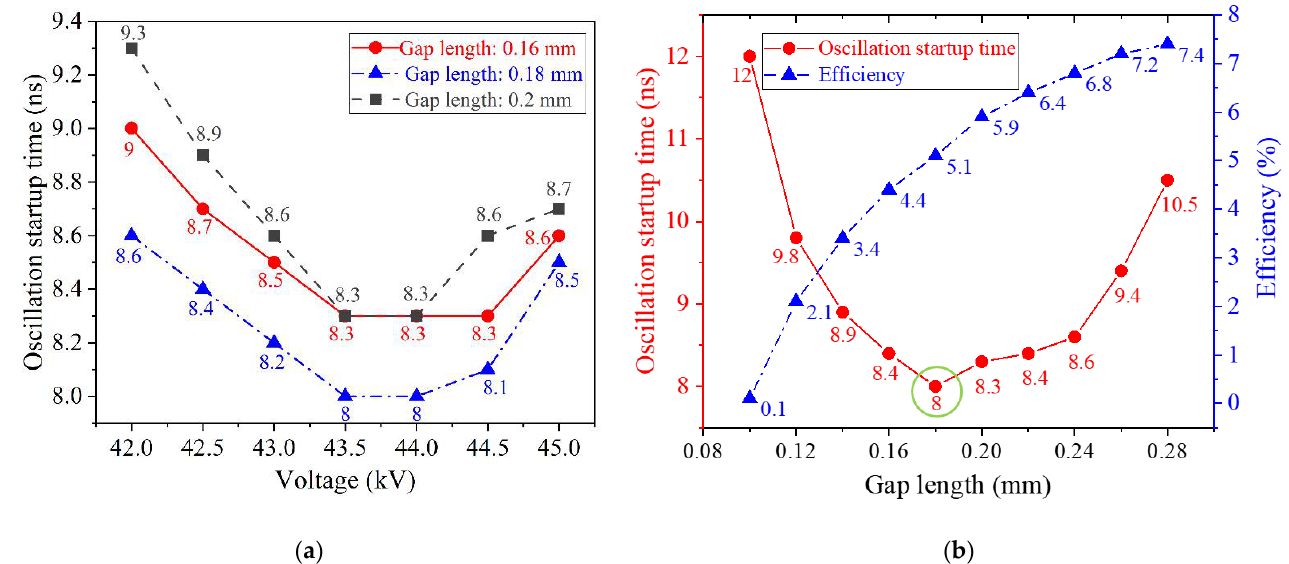
Figure 8. ( a ) The change trends of the EIO’s OST with the voltage (three various gap lengths); ( b ) The impact of the gap length on the shortest OST and the efficiency.